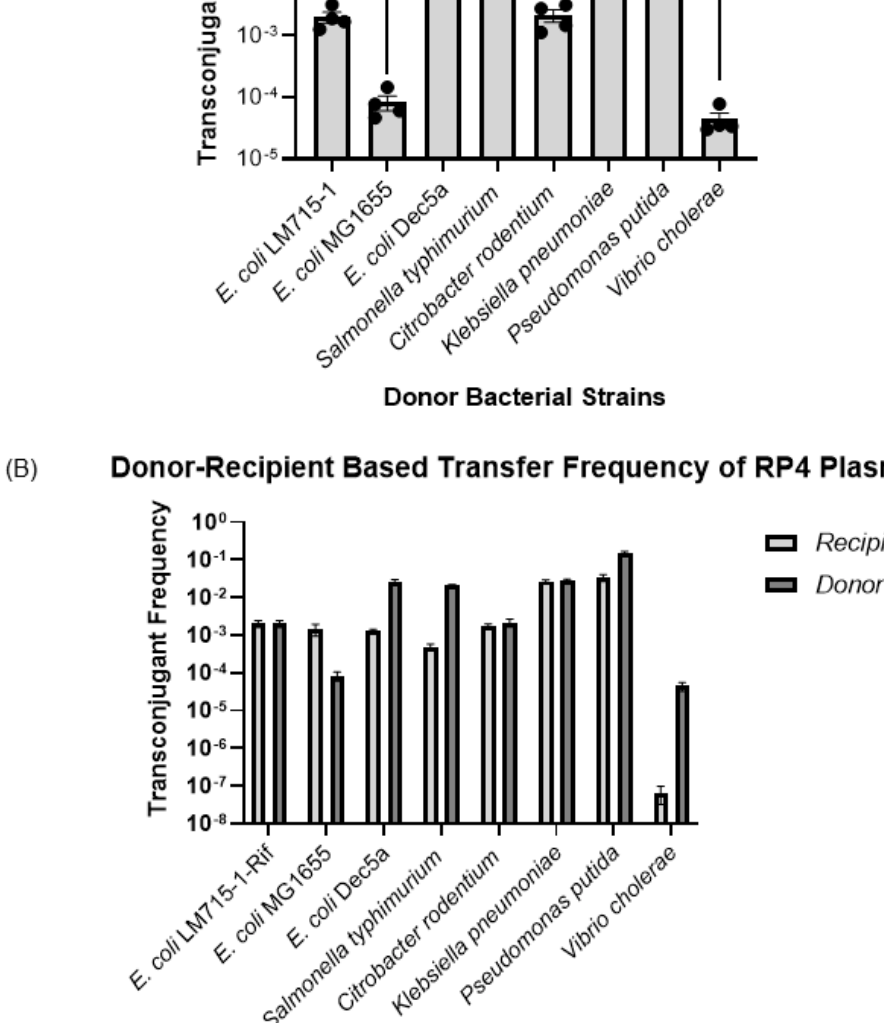
Figure 4. Transfer frequencies of RP4 plasmid to E. coli LM715-1 from different donor strains. ( A ) Secondary transfer frequencies of the BHR RP4 plasmid from different recipient bacterial strains shown in Figure 3 back to the commensal recipient E. coli LM715-1 strain. The plasmid transfer frequencies for all recipients were calculated using the formula (plasmid transfer frequency = transconjugants/(transconjugants + recipients)). Bars indicate mean values ± standard error of the mean (SEM) based on four independent replicates (n = 4) performed for each conjugation experiment. For each donor, frequency of transfer to E. coli LM715-1 was compared to transfer frequency from E. coli LM715-1:RP4 to E. coli LM715-1 RifR. We used Welch’s t -test instead of an unpaired independent samples t- test if there were unequal variances between compared groups; only significant p values are annotated in the graph: * = p ≤ 0.05, ** = p ≤ 0.01, *** = p ≤ 0.001. ( B ) Transfer frequencies for each strain in the primary transfer (when acting as recipient) and the secondary transfer (when acting as donor) of the RP4 plasmid.